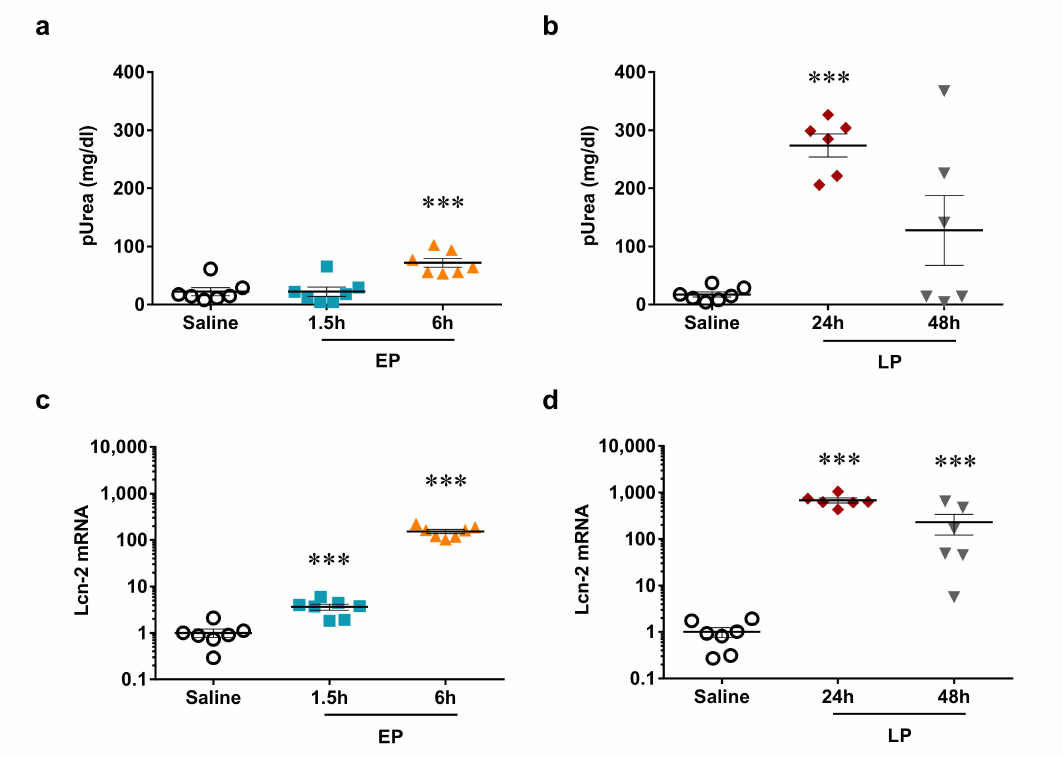
Figure 2. Acute kidney injury markers. ( a , b ) Plasma urea concentration after LPS injection, ( a ) EP, 1.5 and 6 h, ( b ) LP, 24 and 48 h; ( c , d ) Lcn-2 mRNA normalized to GAPDH (fold changes vs. saline), ( c ) EP, 1.5 and 6 h, ( d ) LP, 24 and 48 h. Data are expressed as mean ± SEM; one-way ANOVA; ***: p <